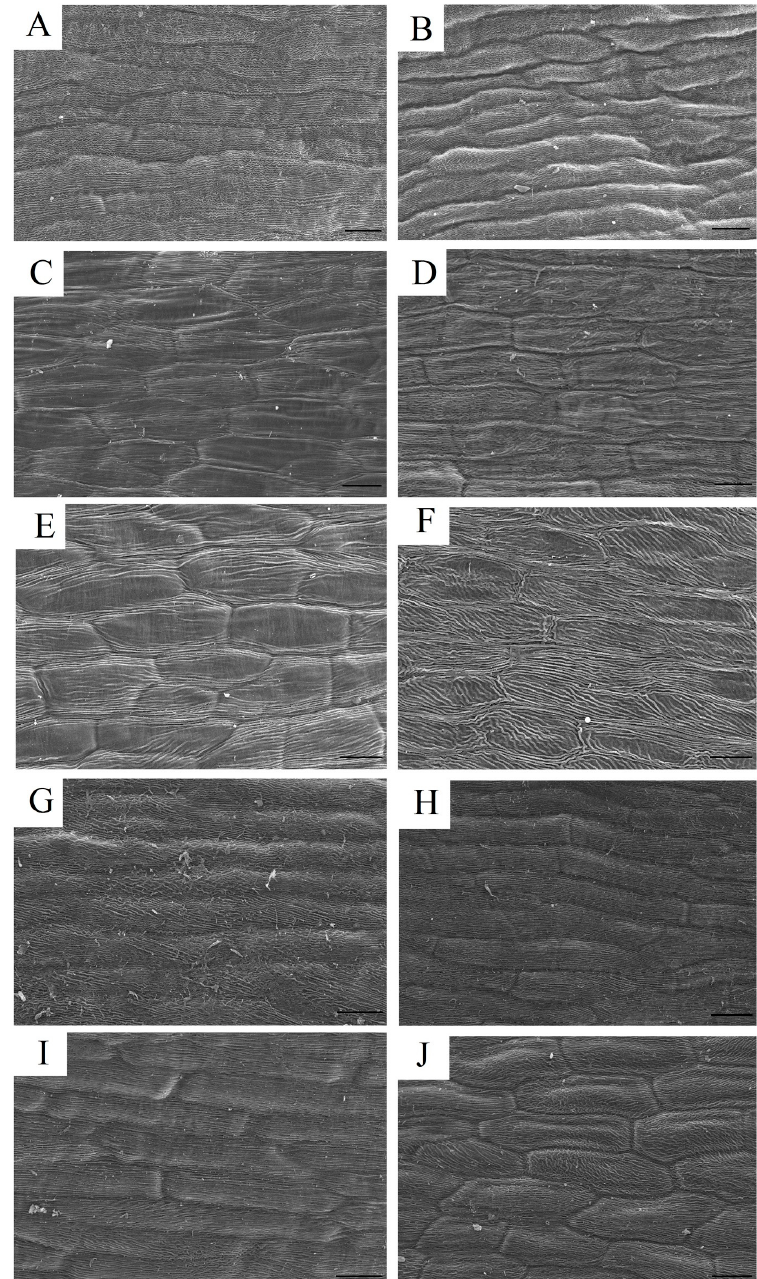
Figure 3. Scanning electron micrograph (SEM) of papillate cells from the outer epidermis of petals from the materials. Bar = 40 μ m. (( A , B ), ( E , F ) and ( G , H )) the upper and lower epidermis of the background petals of P. rockii , P. ostii and the F1 progeny, respectively. (( C , D ) and ( I , J )) the upper and lower epidermis of the variegated petals of P. rockii and the F1 progeny, respectively.